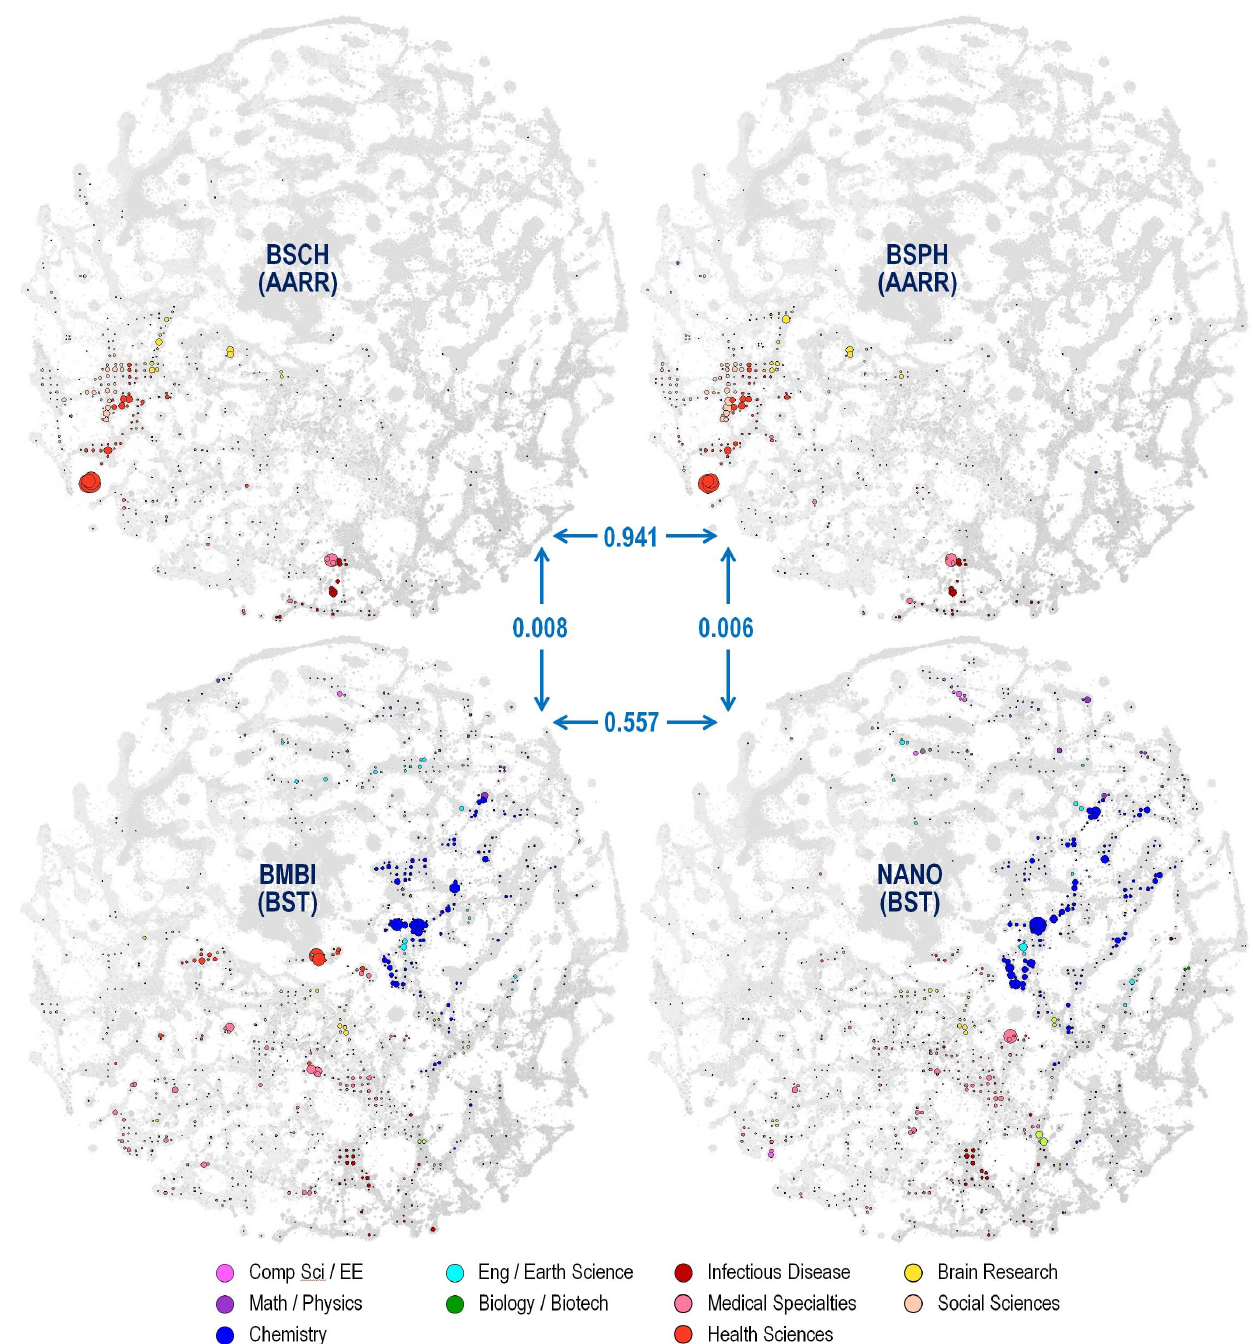
Figure 5. Visual comparison of the locations of reviewer publications for four study sections on the base map of science. Cosine values between pairs of study sections are indicated at the interior of the figure.